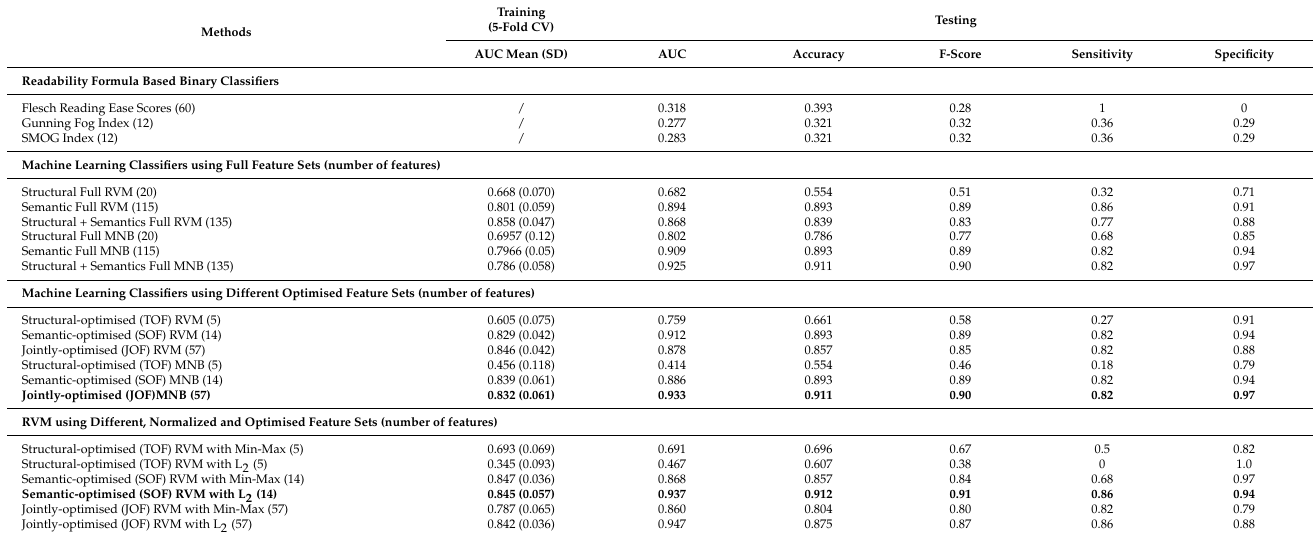
Table 1. Performance of readability formulas, relevance vector machine (RVM) and multinomial naïve Bayes (MNB) on training and testing data with different features and data normalization methods. CV: cross validation. Bold: to indicate the best model